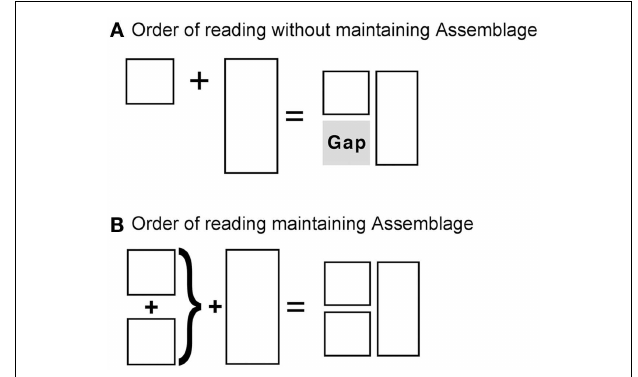
FIGURE 6 | Blockage preferences